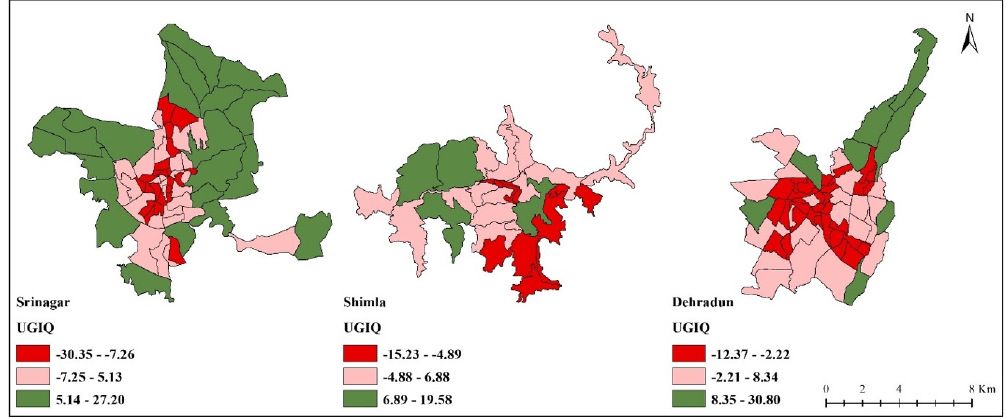
Land 2023 , 12 , x FOR PEER REVIEW Figure 7. UGIQ variation at ward level in three cities. Figure 7. UGIQ variation at ward level in three cities.